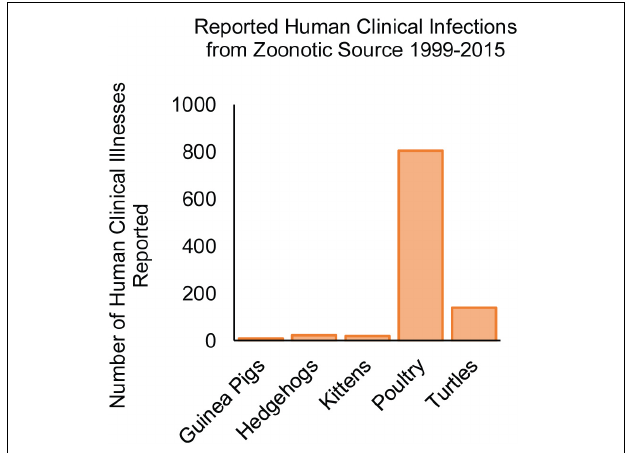
FIGURE 8 | NTS serovars associated with zoonotic infections in the United States from 1999 to 2015. The number of human clinical infections resulting from animal contact is shown according to the source of the infection (Centers for Disease Control and Prevention [CDC], 2001; Wright et al., 2005; Loharikar et al., 2012; Bartholomew et al., 2014; Nakao et al., 2015; Anderson et al., 2016, 2017; Gambino-Shirley et al.,